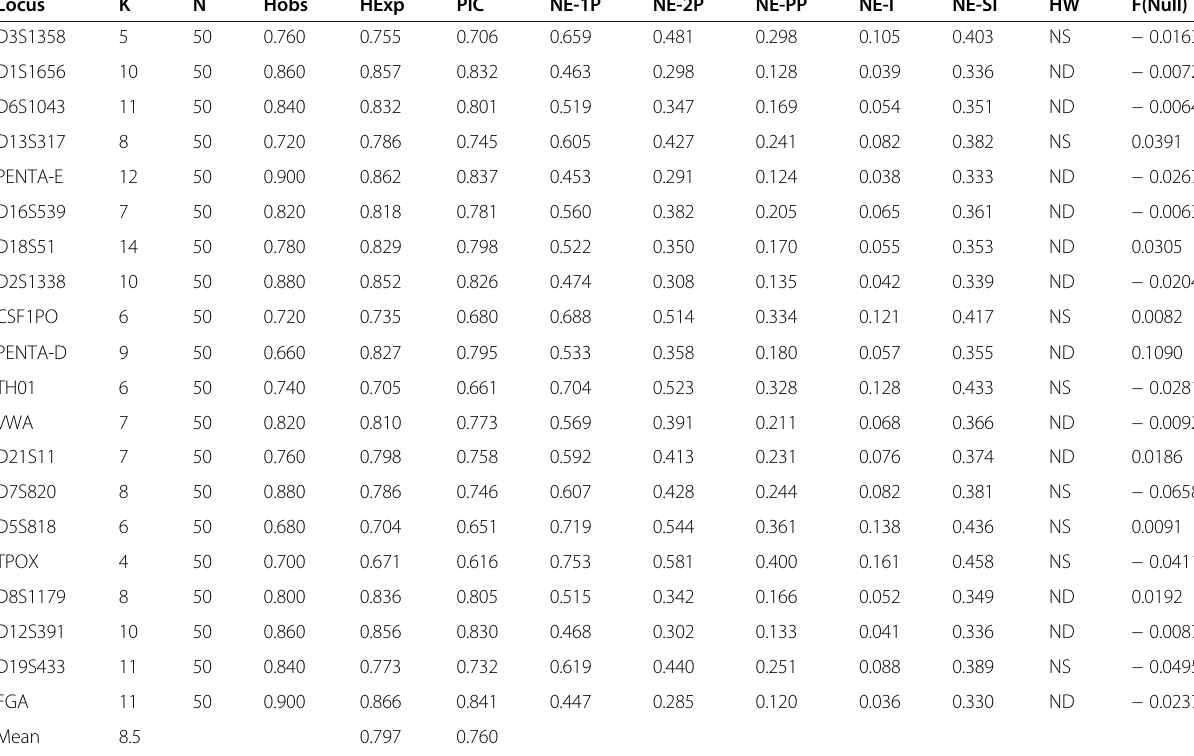
Table 2 Cervus output representing the number of alleles per locus (k), number of individuals (N), observed (Hobs) and expected (Hexp) heterozygosity, polymorphic information content (PIC), combined non-exclusion probability for first parent (NE-1P), second parent (NE-2P), parent pair (NE-PP), identity (NE-I) and sib identity (NE-SI), the Hardy – Weinberg equilibrium significance (HW), and the F test